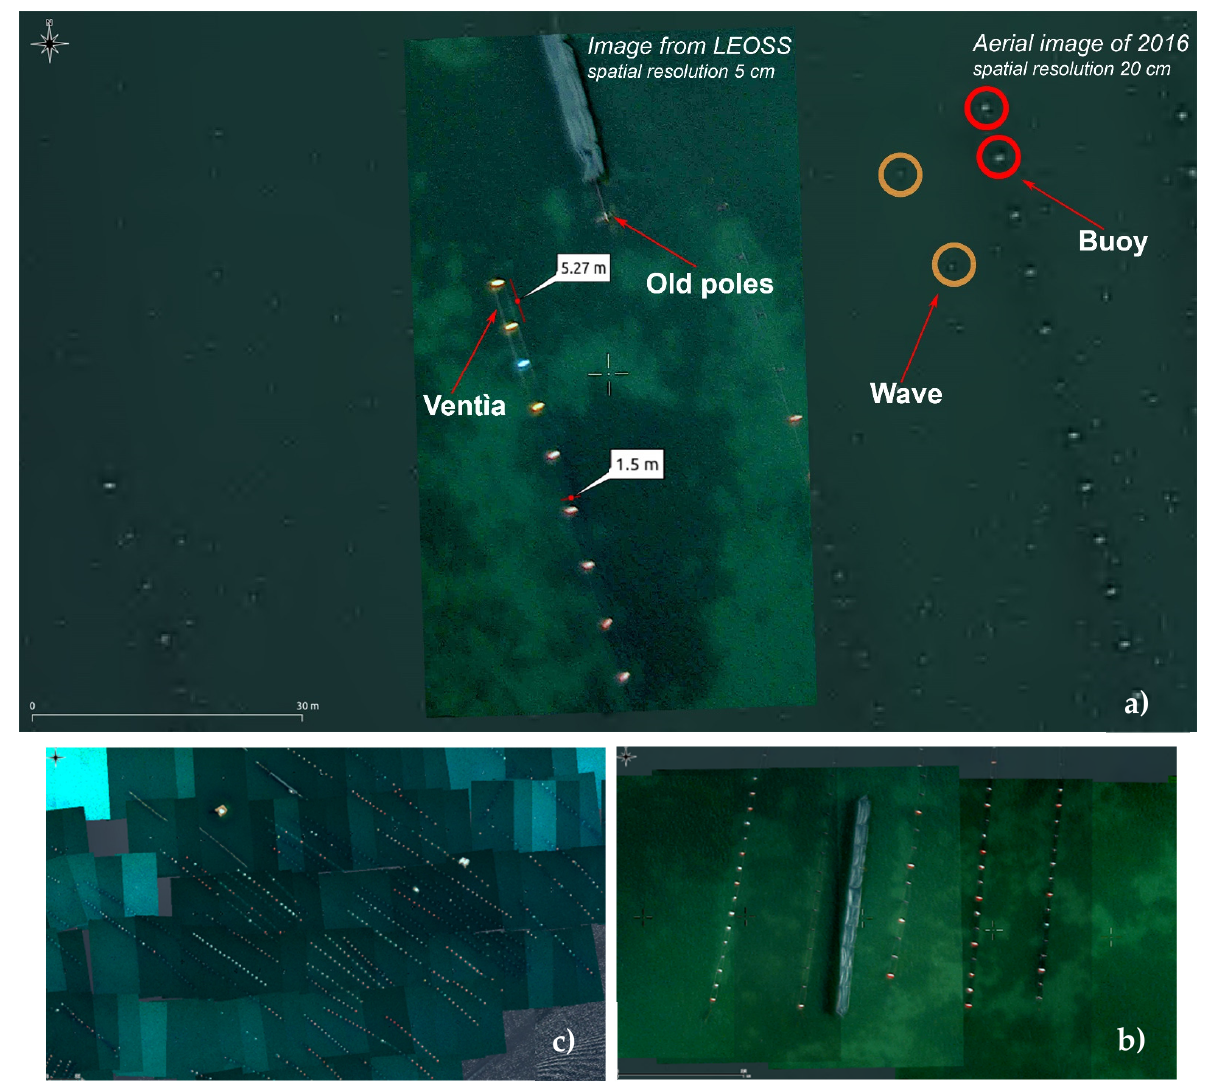
Figure 10. ( a ) Example of details identifiable with LEOSS unlike the aerial images of Puglia of 2016; ( b ) Detail of the part of the overall mosaic of all mussel farms; ( c ) Magnification of the high degree of detail provided.